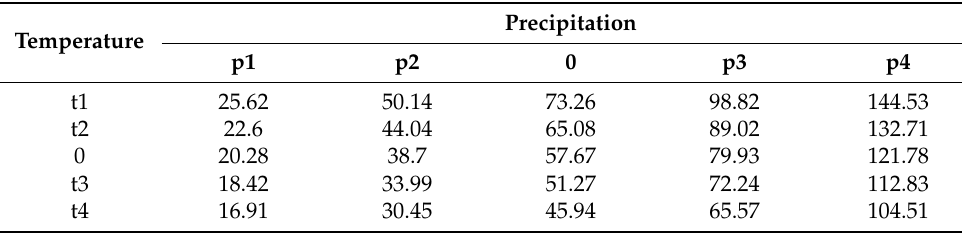
Table 7. The monthly average simulated runoff at Linjiacun Station under different climate scenar- ios (m 3 · s − 1 ).